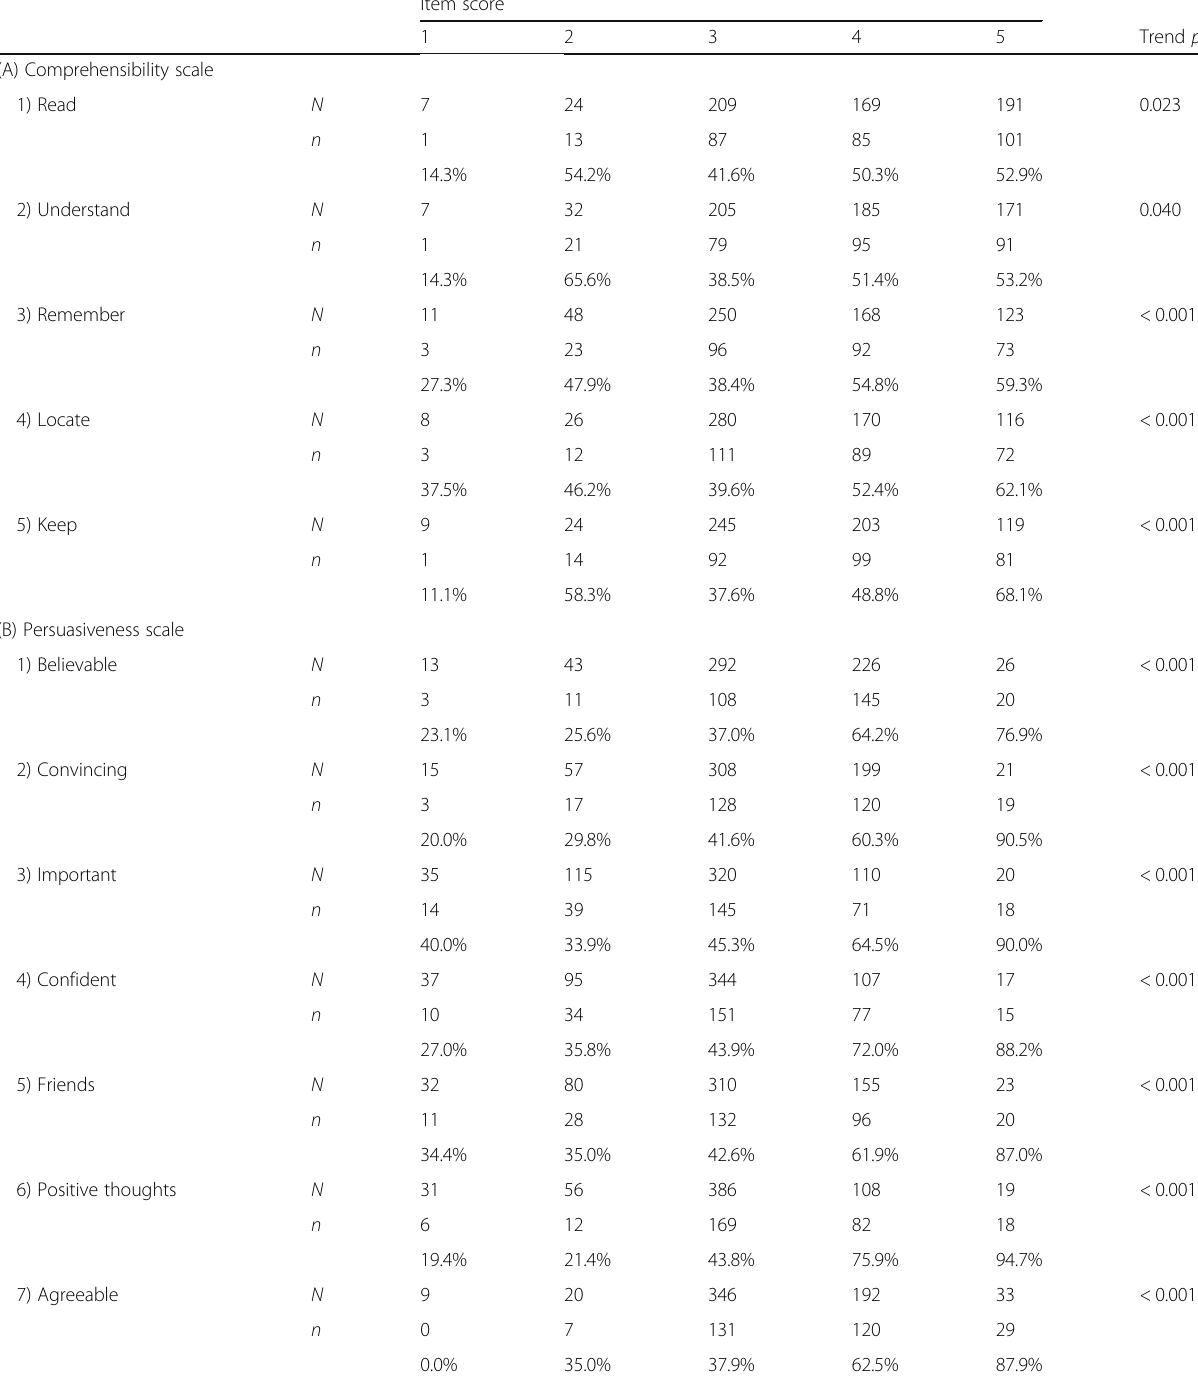
Table 6 Association between each item score and help-seeking intention for insomnia Item score 1 2 Trend